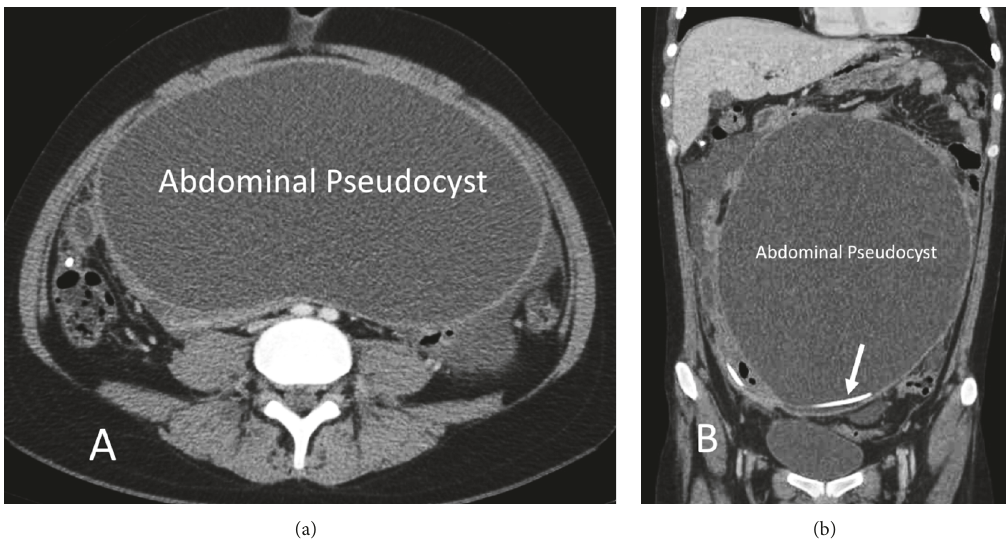
Figure 4: Axial (a) and coronal (b) noncontrast CT reformatted images at about 9 months after ventriculoperitoneal shunt placement. Large thick-walled abdominal pseudocyst with smooth walls. Note VP shunt catheter within the base of the cyst (arrow,